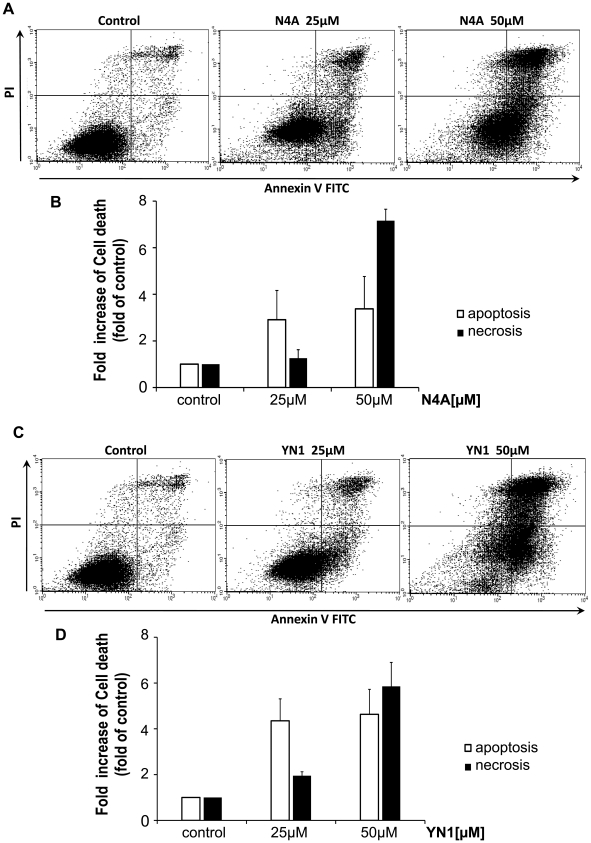
Induction of cell death in HeLa cells by the PFKFB3 inhibitors, N4A and YN1.The cells were treated with two different concentrations of inhibitors, 25 µM and 50 µM. (A) Induced cell death at two different concentrations of N4A was measured by flow cytometry after double staining with Annexin V and PI. (B) Quantitation of the flow-cytometric data (mean ± SD) showing a dose-related effect of N4A. (C) Cytograms of YN- induced cell death and (D) quantitation of the flow-cytometric data.